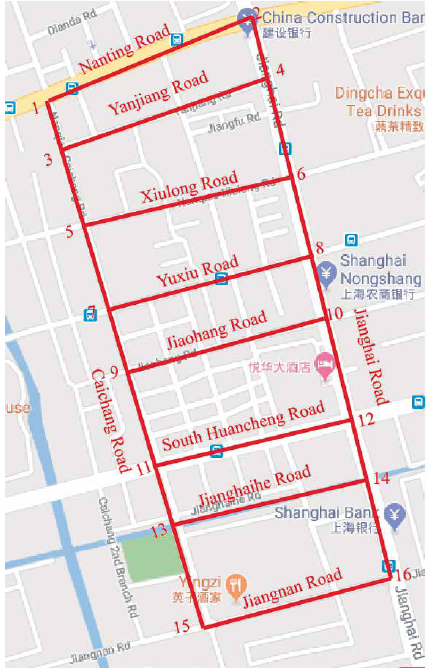
Figure 1: Testing area and the driving path. (Images are from google